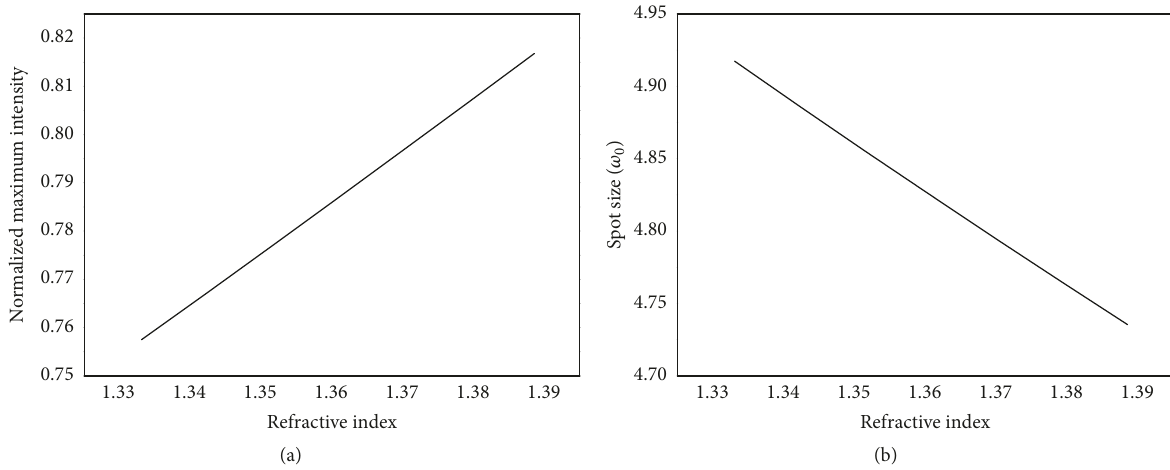
Figure 8: Relation between optical parameters of GB and NaCl solution refractive index, 𝜔 0 =0.1 × 10 −3 m, 𝑛 𝑟 =1.55, 𝜔 𝑝𝑒 = 𝜔 𝑝𝑚 = 2𝜋 ] × √2.55 , 𝑍 𝐿 =2 𝑍 𝑅 = 𝑍 𝑙 =0.2m, 𝑟 =0.2m, and 𝜆 =632.8nm fixed: (a) beam intensity distribution curve; (b) beam spot size curve. 𝑅 =4.9646cm, 𝑅 , 𝑅 ,